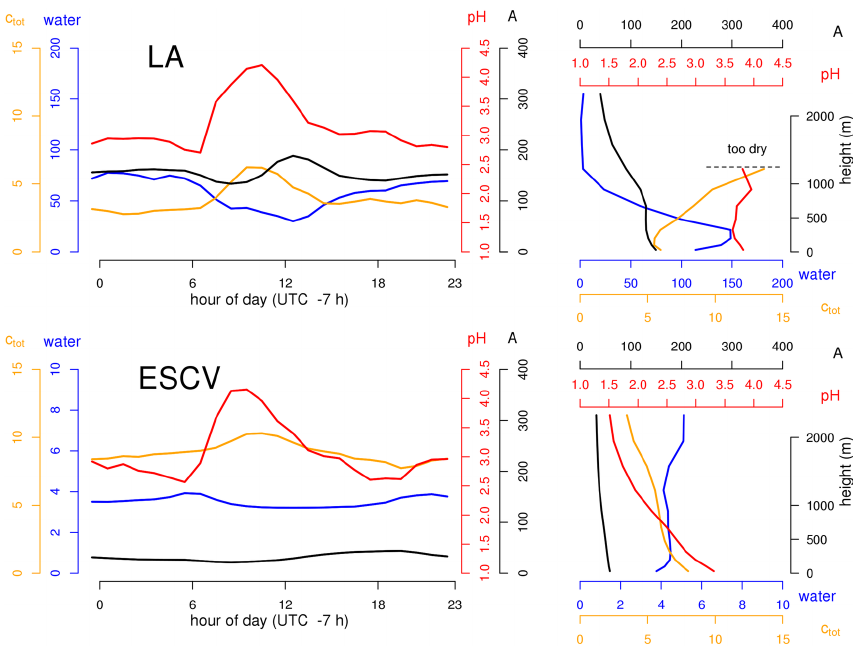
Figure 11. Averaged diurnal cycles (left panels) and vertical evolution (right) of environmental parameters affecting SOA formation from glyoxal in the two different focus regions: salt concentration in deliquesced particles c tot (molkg − 1 ), aerosol water content (µm 2 cm − 3 ), particle acidity (pH), and aerosol surface area A (µm 2 cm − 3 ). Note different scales for water content between LA and ESCV. Values for pH and c tot masked above 1200ma . g . l . in LA due to too few data points for statistically sound averaging.